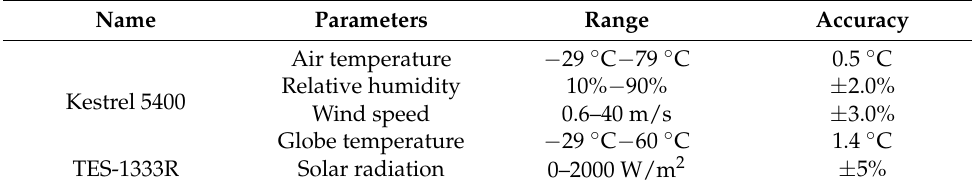
Table 2. Instruments used for micro-meteorological variables measurement.